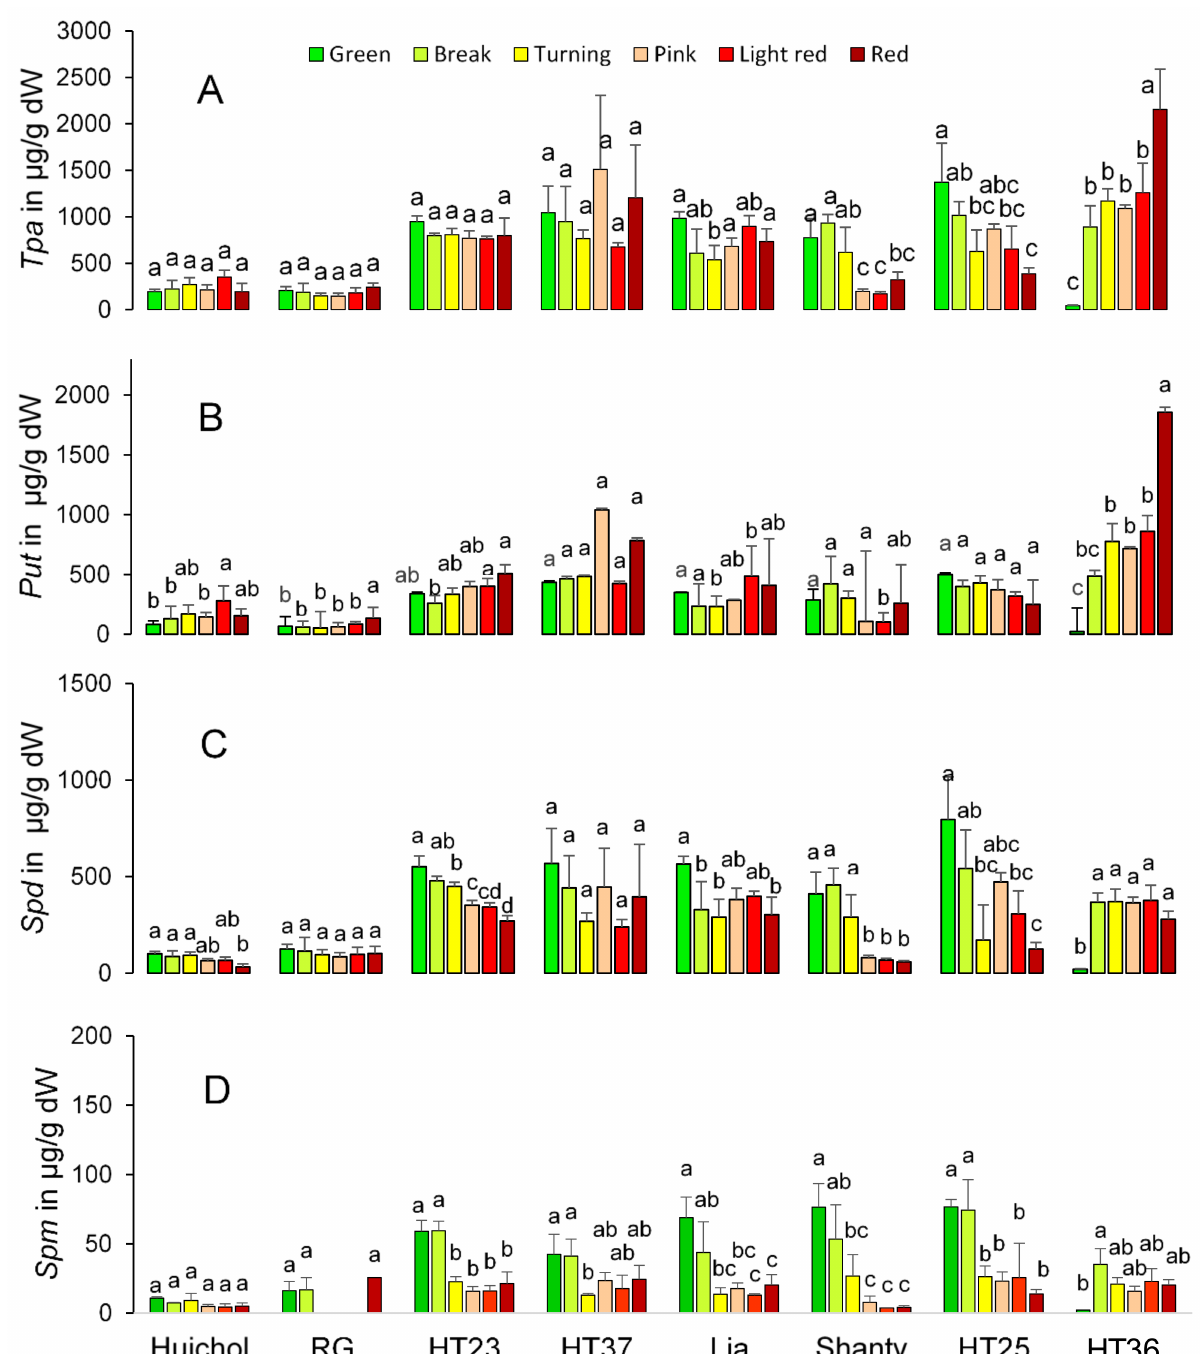
Figure 3. Content of Tpa (total polyamines ( A )), Put (putrescine ( B )), Spd (spermidine ( C )) and Spm (spermine ( D )) in µ g/g dW of eight tomato genotypes (‘Huichol’, ‘Rio Grande’ (RG), ‘HT23’, ‘HT37’, ‘Lia’, ‘Shanty’, ‘HT25’ and ‘HT36’) at six maturity stages (green, break, turning, pink, light red and red). Values are the average of three to four samples. Bars indicate standard deviations. Letters above the staples that differ indicate significant differences ( p < 0.05 using Tukey post hoc test) between tomatoes of different maturity stages within the same genotype. A comparison of statistical differences among mean values of all genotypes and stages is shown in Table